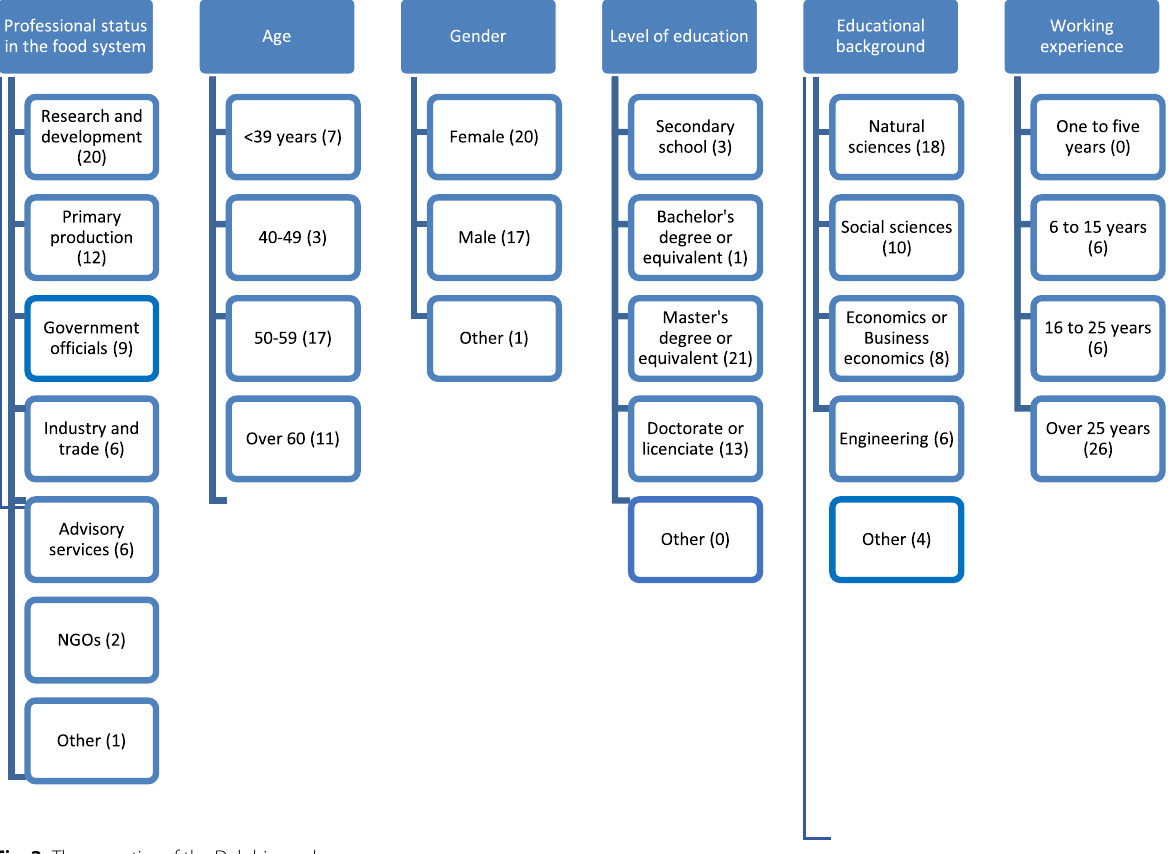
Fig. 2 The expertise of the Delphi